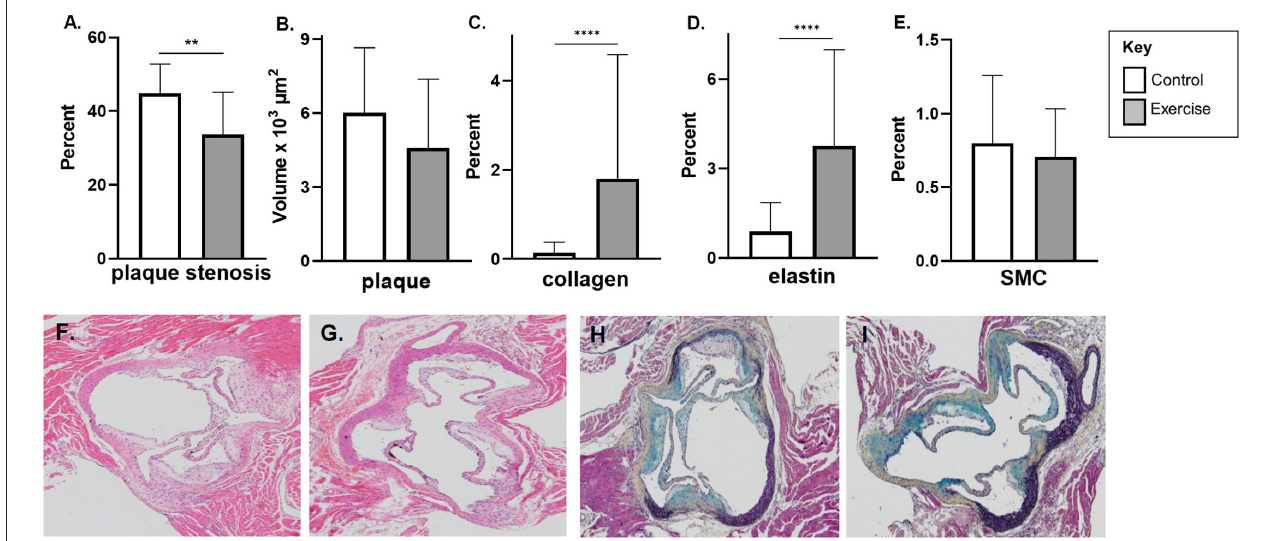
FIGURE 2 | The effect of exercise on plaque volume, degree of stenosis, and composition in an early-stage model of atherosclerosis. Male chow fed apoE -/- mice with early-stage plaques were exposed to exercise for 10 weeks at 12 weeks of age. Aortic sinus sections were assessed for (A) plaque volume, (B) plaque % stenosis, (C) vessel elastin, (D) plaque collagen and (E) plaque SMC content. Data are expressed as mean ± SD. SMC; smooth muscle cell. The x -axis represents the control (white bar) vs. the experimental (gray bar). Representative H&E stain of the aortic sinus in the control (F) and exercise group (G) . Representative Movat’s stain of the aortic sinus in the control (H) and exercise group (I) with magnification x 600. ** p < 0.01, **** p <